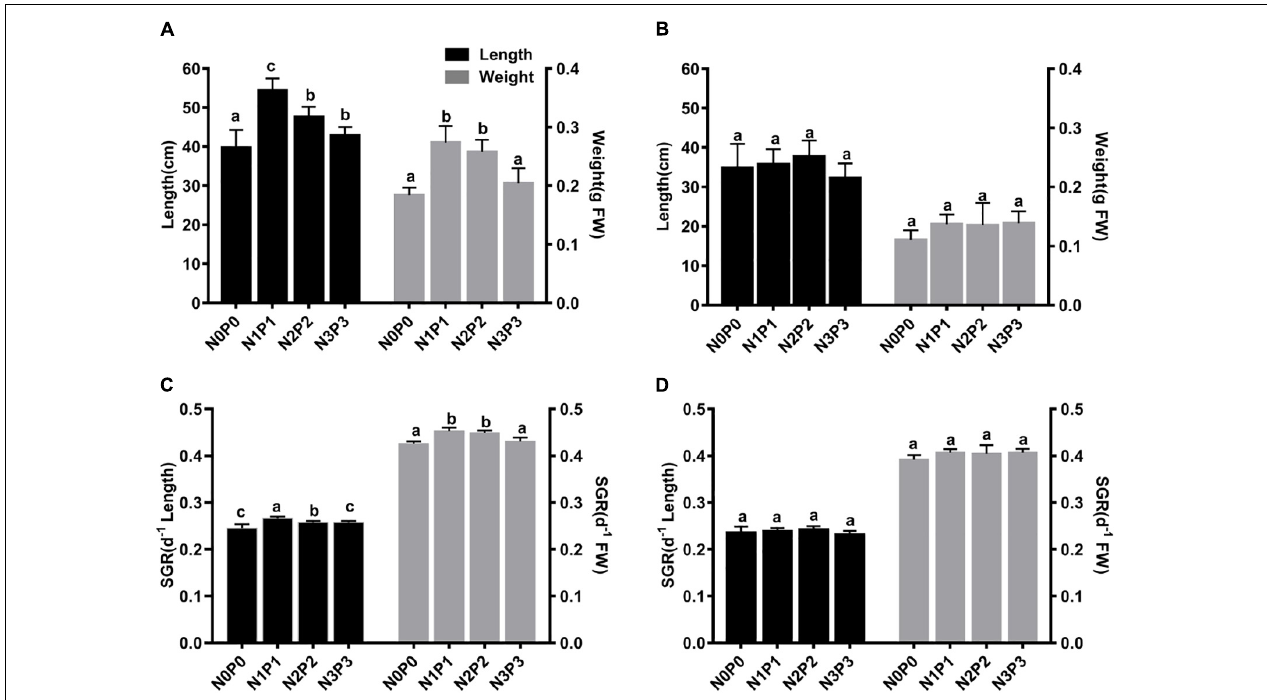
FIGURE 1 | Length (black bars) and fresh weight (gray bars) of Z-61 (A) and Z-26 (B) thalli after 15 days of incubation. Specific growth rate of Z-61 (C) and Z-26 (D) cultured under different nutrient contents. From N0P0 to N3P3, the NO 3 − contents were 0.61, 1.81, 5.29, and 13.16 mg/L, while the PO 43 − contents were 0.09, 0.19, 0.65 and 1.34 mg/L, respectively. Values are means ± SD ( n = 4). Different letters represent significant differences ( P < 0.05) among treatments.